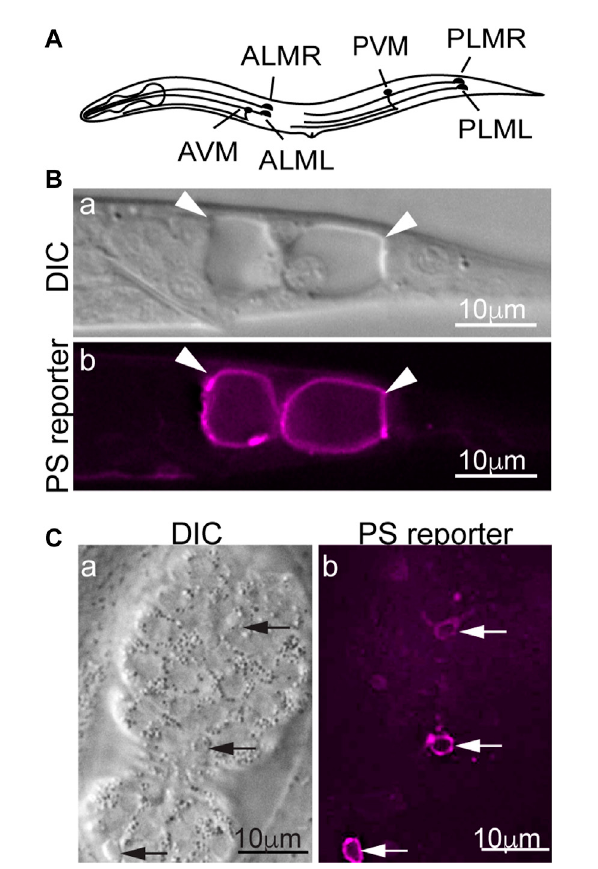
FIGURE 1 PS is detected on the surfaces of necrotic and apoptotic cells in Caenorhabditis elegans . MFG-E8 is a high-af fi nity PS-binding protein. Secreted MFG-E8mKate2 (the PS reporter) interacts explicitly with PS exposed on cell surfaces. (A) A diagram showing the positions and names of the six Caenorhabditis elegans touch neurons. (B) DifferentialInterferenceContrast(DIC)andepi fl uorescenceimagesof the tail of a mec-4(d) L1-stage larva carrying the MFG-E8:: mKate2 reporter. Arrowheads mark the necrotic PLML and PLMR neurons. (C) DIC and epi fl uorescence images of a mid-stage embryo expressing MFG-E8::mKate2. Arrows indicate three apoptotic cells that expose